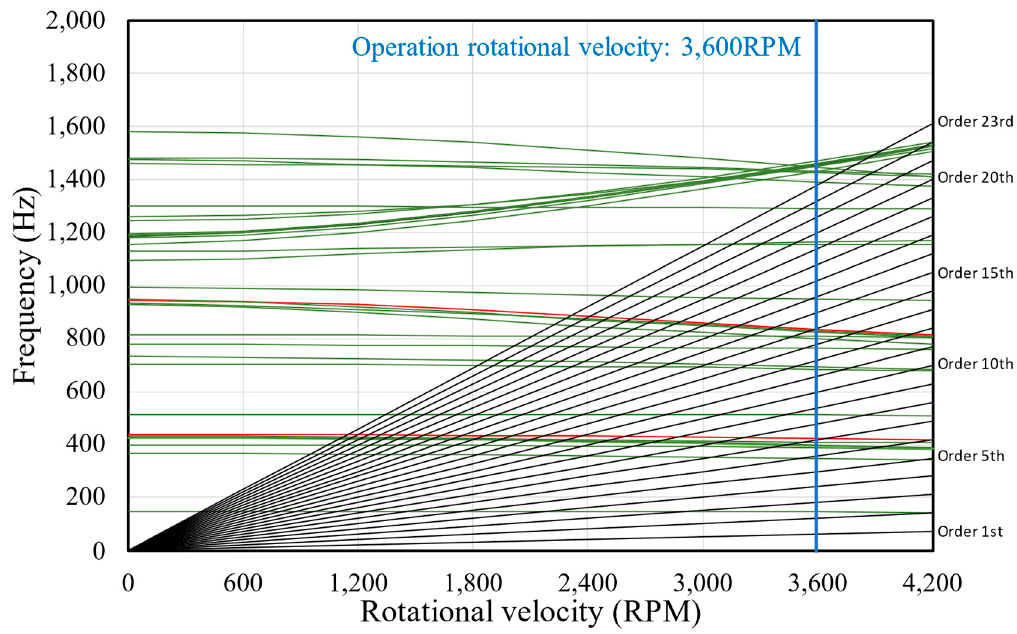
Figure 27. The Campbell diagram of two-stage moving blades.